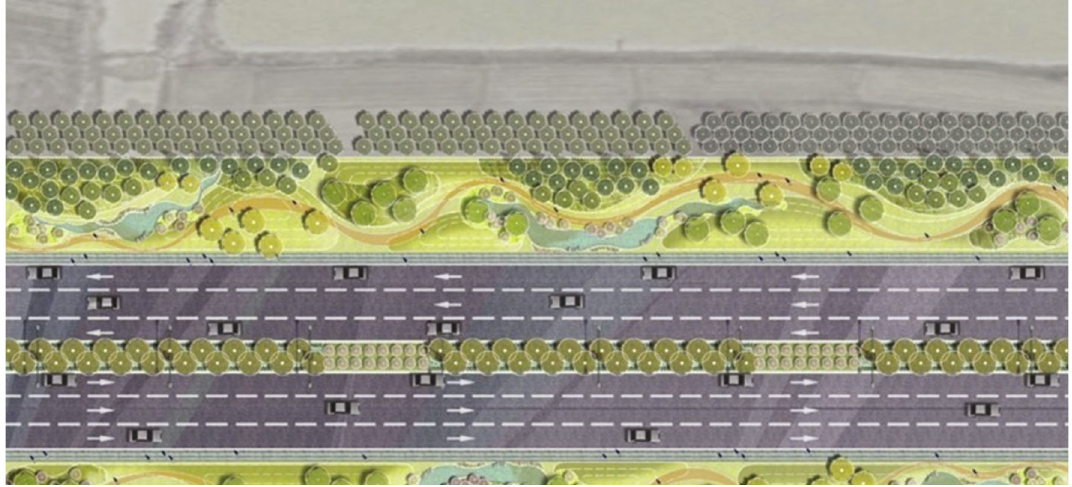
Figure 1: Urban green landscape map of A district in a southwestern